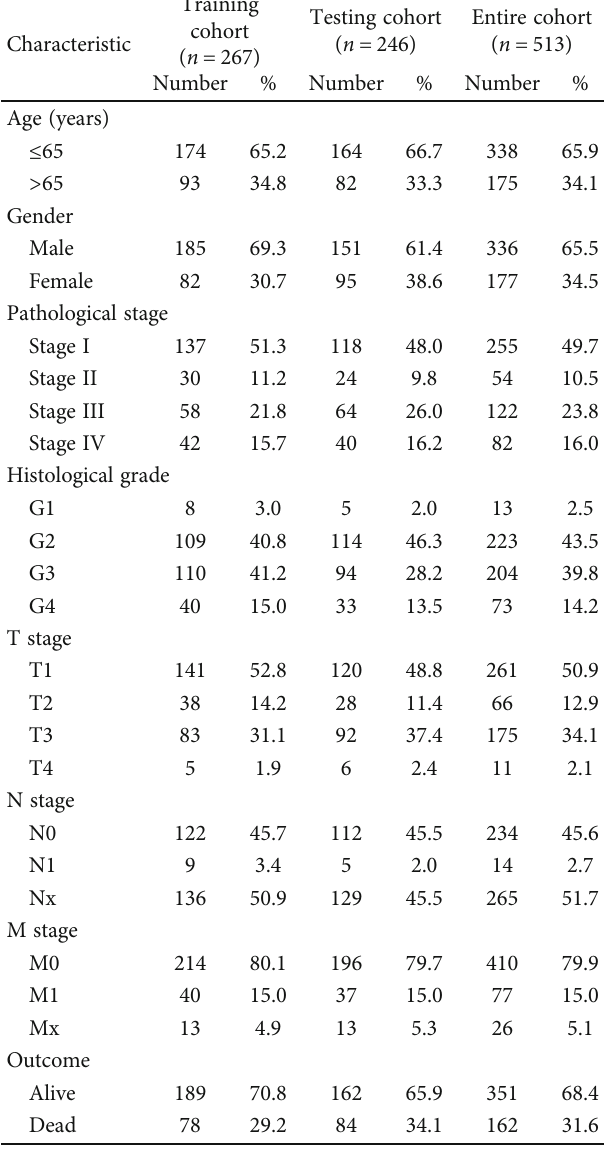
Table 1: Clinicopathological characteristics of patients in the TCGA-KIRC